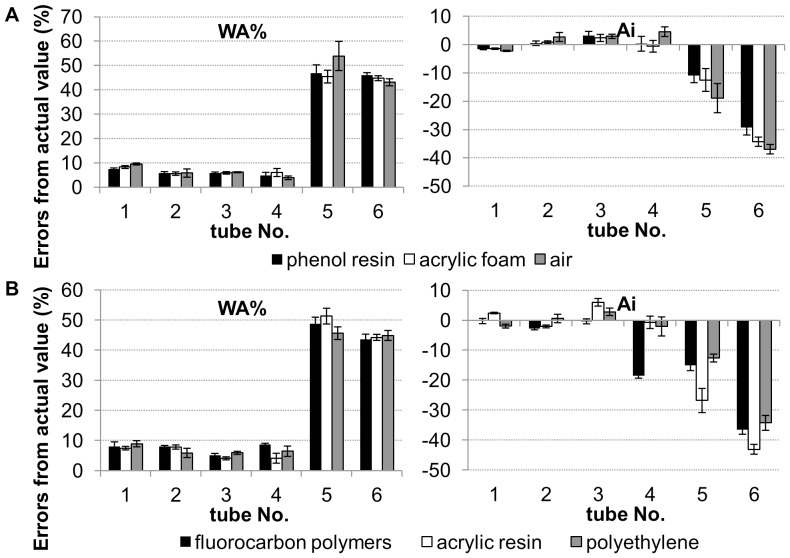
Effects of phantom composition on errors of airway dimension measurement.Percentage error of wall area (WA%) and luminal area (Ai) for the phantom scanned using Aquilion 64 (120 mAs, 0.5-mm slice thickness, 350-mm FOV, lung reconstruction algorithm FC56). A: Comparison of errors of WA% and Ai for acrylic resin tubes among materials simulating lung parenchyma, phenol resin (0.32 g/cm3), acrylic foam (0.10 g/cm3), and air. B: Comparison of errors for WA% and Ai among tube materials, fluorocarbon polymers (2.1 g/cm3), acrylic resin (1.2 g/cm3), and polyethylene (0.9 g/cm3) embedded in acrylic foam.